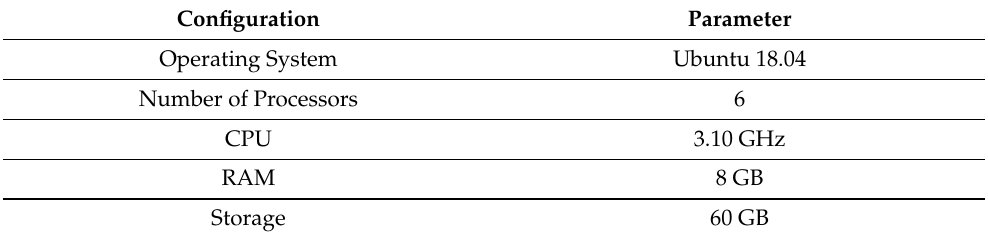
Table 2. System configuration of the experimental